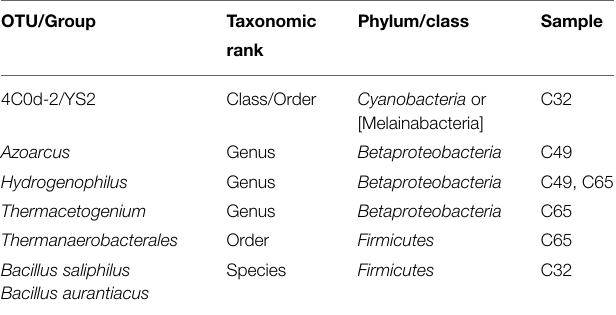
TABLE 2 | Bacterial groups described for the first time in association with carbonate